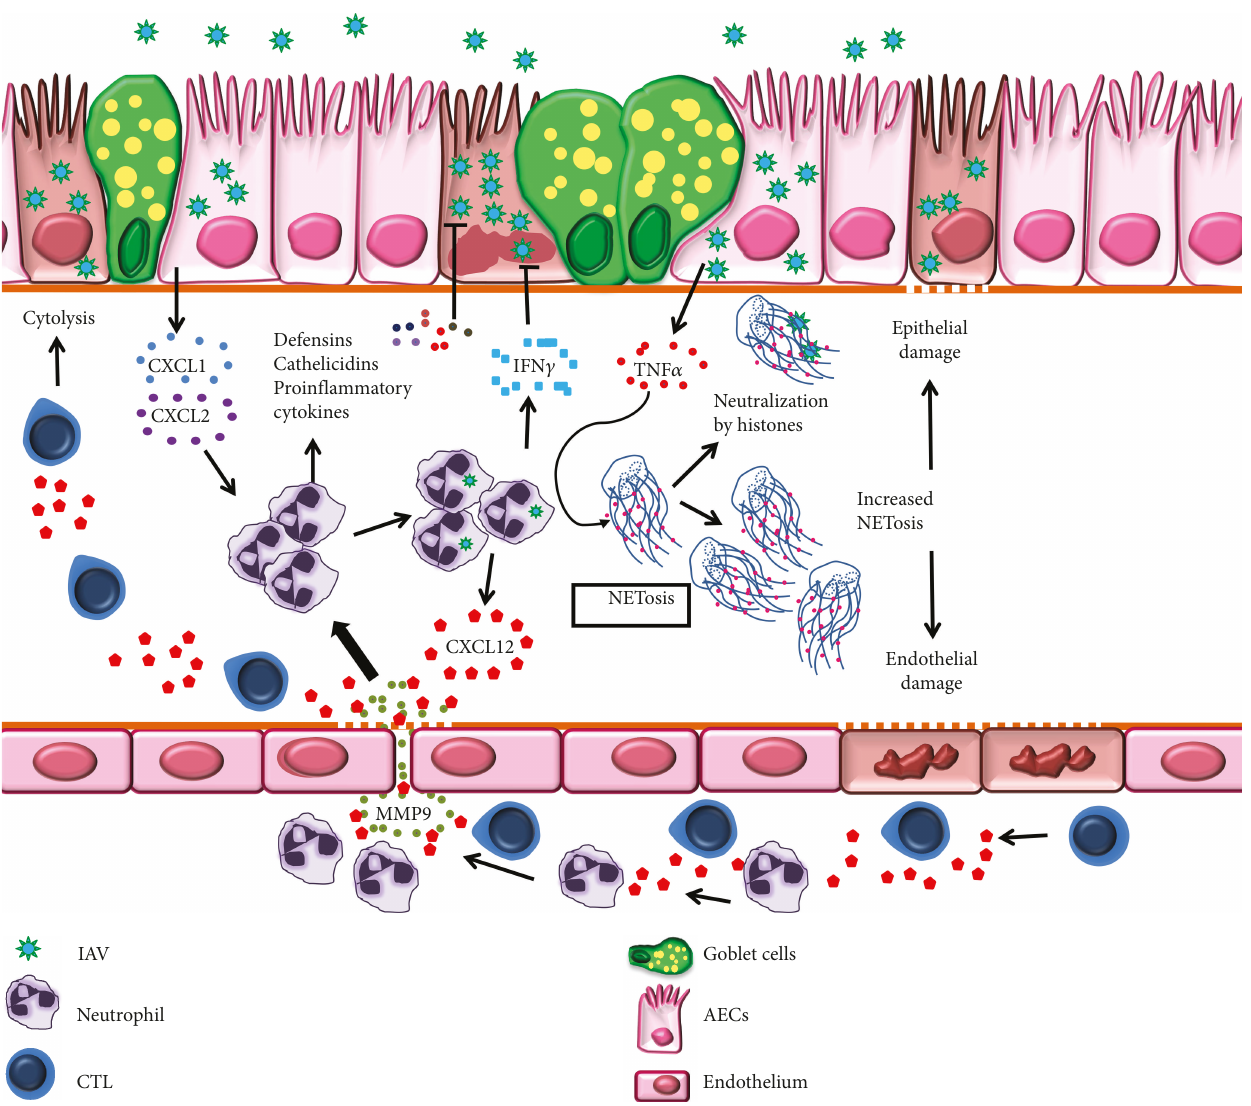
Figure 1: Schematic representation of neutrophil-mediated host defense mechanisms during in fl uenza virus infection. In fl uenza A virus- (IAV)-infected airway epithelium releases neutrophil chemoattractants: CXCL1 and CXCL2. Neutrophils tra ffi c into infected lungs by digesting endothelial basement membrane collagen. During tra ffi cking, they release CXCL12-loaded vesicles/membranes which provide signals for CD8 + T cell migration and e ff ector function. Once in the lungs, neutrophils secrete antimicrobial peptides and cytokines, including IFN γ , to inhibit IAV replication. TNF α produced by infected airway epithelium triggers the formation of neutrophil extracellular traps (NETs) which neutralize IAV particles. Enhanced NETosis damages airway epithelium and endothelium leading to severe